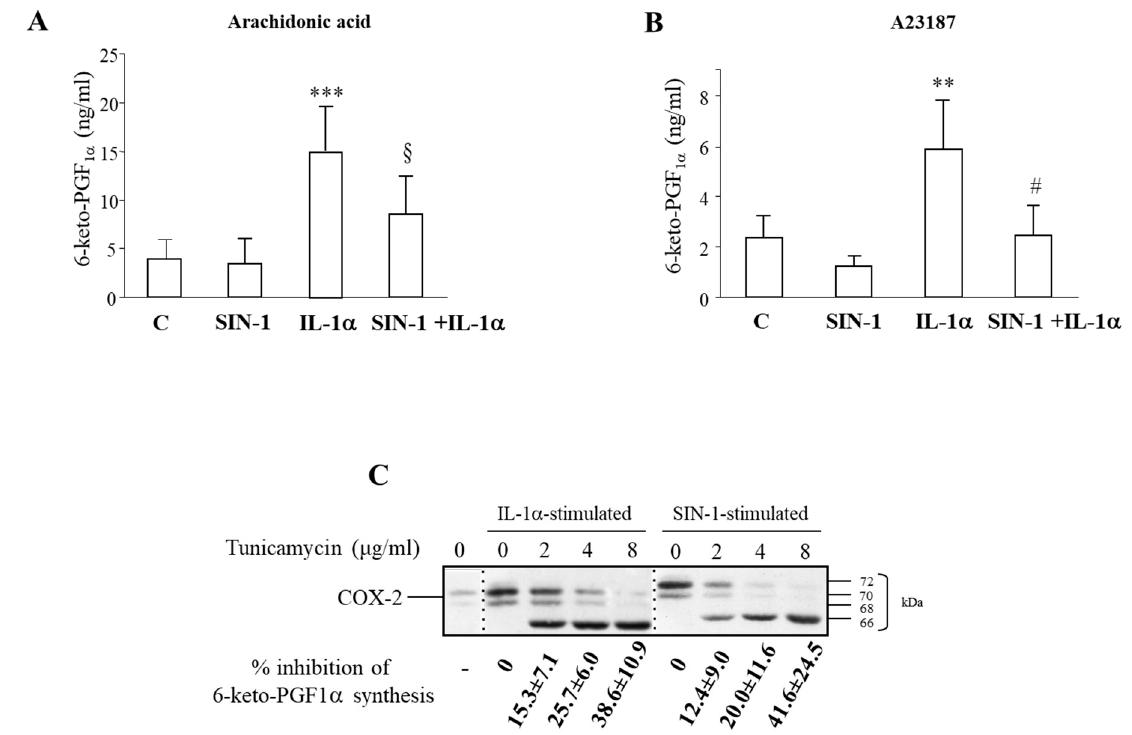
Figure 6. SIN-1 inhibits the prostaglandin production. HUVEC were treated for 18 h with SIN-1 or IL-1 α either alone or in combination. ( A ) 6-keto-PGF 1 α production was measured after the exposure of cells to 10 μ M arachidonic acid for 30 min. n = 17 independent experiments; *** p < 0.001 vs. unstimulated cells; § p < 0.001 vs. IL-1 α stimulated cells). ( B ) Prostaglandin production was measured after the exposure of cells to 2 µ M calcium ionophore A23187 for 30 min; n = 5; ** p < 0.01 vs. unstimulated cells; # p < 0.01vs. IL-1 α . ( C ) HUVEC were incubated with SIN-1 or IL-1 α in the presence or absence of different concentration of tunicamycin for 6 h and Western blot analysis was performed. The lanes were run on the same gel but were non-contiguous. Results are representative of 4 independent experiments. 6-keto-PGF 1 α levels were measured by EIA.